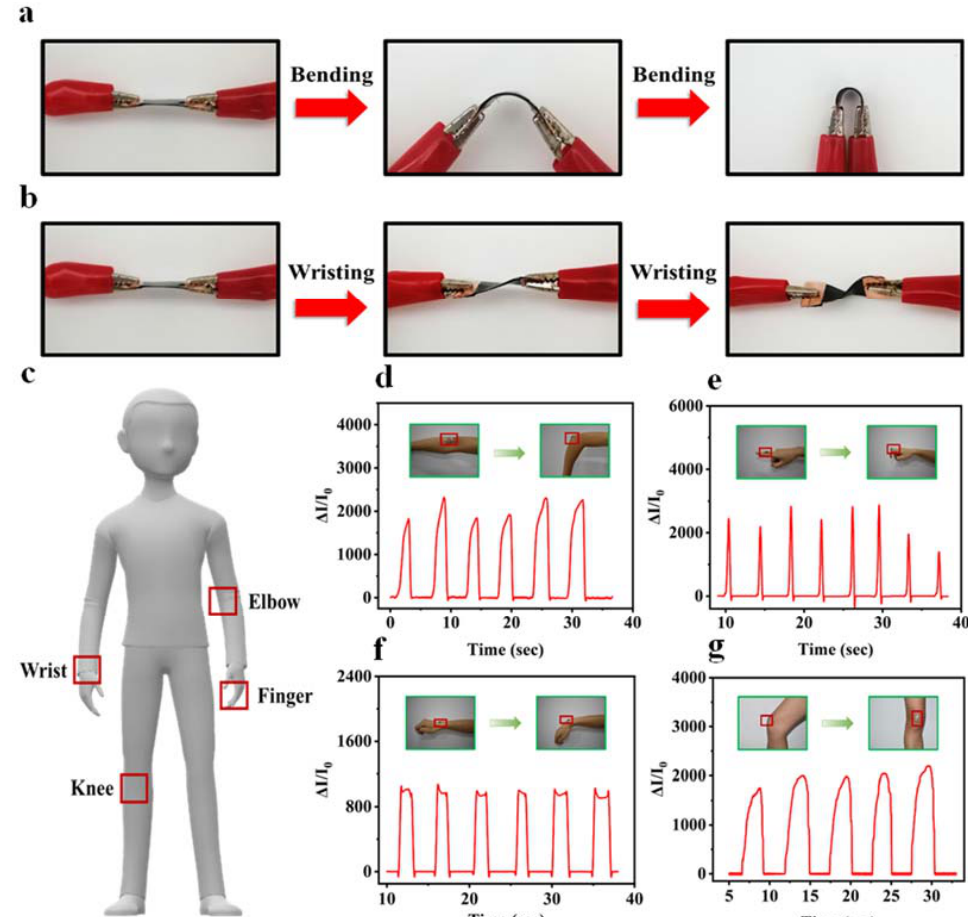
Figure 8. Applications of the SF/Gr flexible pressure sensor in real-time monitoring of human activity and detection of physical signals. ( a ) distortion of SF/Gr sensor during bending; ( b ) distortion of SF/Gr sensor during twisting; ( c ) schematic diagram of human motion test; ( d – g ) elbow, finger joint, wrist, knee, and motion signal schematic diagram.